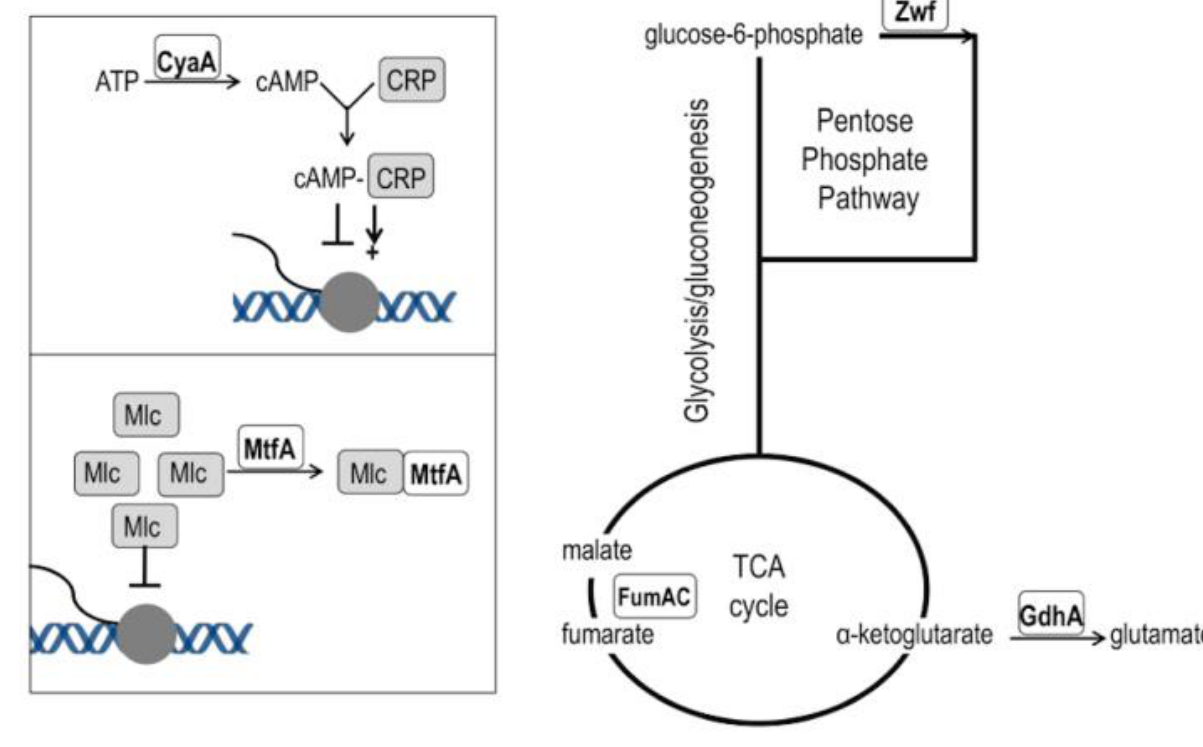
FIGURE 5: Network position of purH suppressor mutations. Loss-of-function mutations that suppress the thiamine requirement of a purH mutant have a role in various aspects of central carbon metabolism. The cyaA gene encodes adenylate cyclase and its product (cAMP) is the effector of the CRP transcriptional regulator that modulates >100 genes [45]. The mtfA gene encodes the Mlc titration factor; Mlc is a global regulator of sugar metabolism. Both cAMP-CRP and MtfA are part of the PTS signal transduction pathway [46]. Fumarate dehydratase ( fu- mAC ) and glutamate dehydrogenase ( gdhA ) function in, or just peripheral to, the TCA cycle. Glucose-6-phosphate dehydrogenase ( zwf ) is the first enzyme of the oxidative pentose phosphate